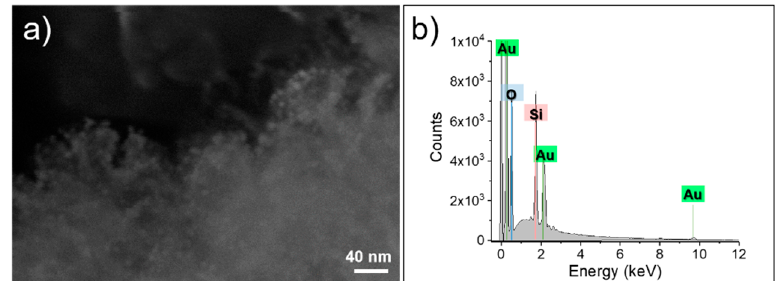
Figure 2. FE-SEM images ( a ) and elemental composition analysis ( b ) of s-MSN-Au sample.